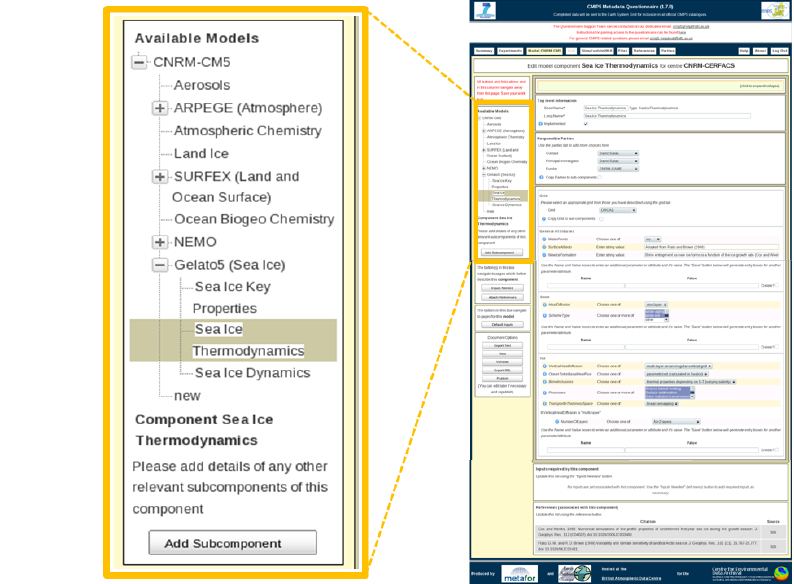
Fig. 7a. How the model pages of the CMIP5 Questionnaire automatically inherit from the CV mindmap organization. Components’ hierarchy (realm and child components) determines the model navigation tree (left column, enhanced in the zoom).